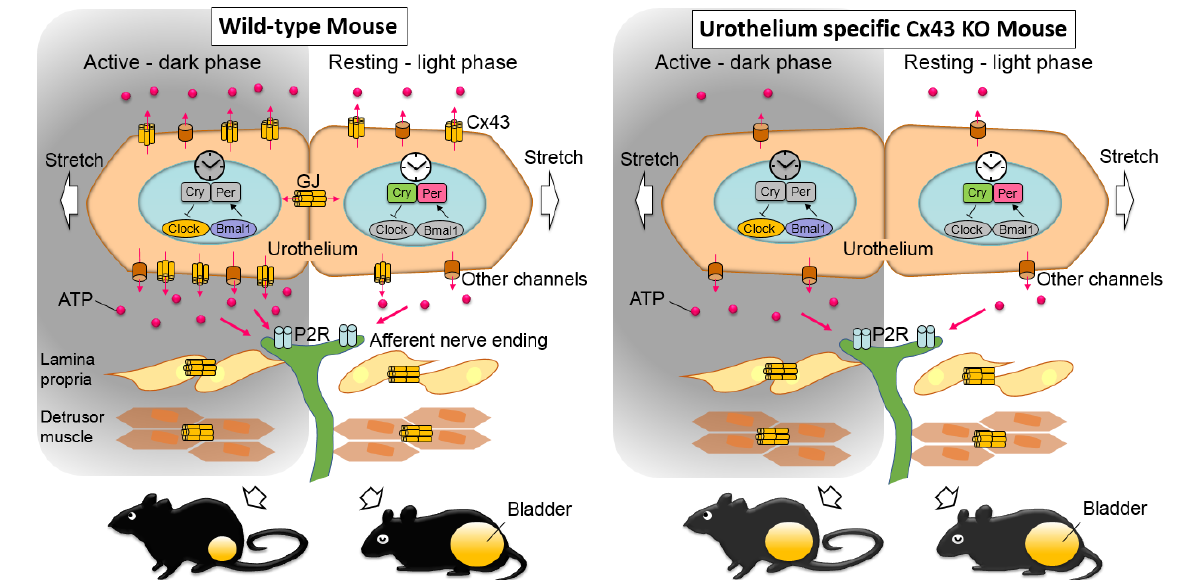
Figure 5. A schematic model of the events occurring in the wild-type mouse and in the urothelial specific Cx43 KO mouse, focusing on urothelial Cx43, ATP, and functional bladder capacity (Figure modified from supplement of [8]). In uCx43KO mice, downregulation of Cx43 expression in the urothelium results in reduced urothelial ATP release, especially in the animals’ active phase (night-time). The day–night differences in the urothelial ATP release and the functional bladder capacity are attenuated in uCx43KO mice that, in the active phase, displayed lower ATP release and higher functional bladder capacity than WT mice. Urothelial ATP signaling via Cx43 gap junction and hemichannel lead to stimulate P2 purinergic receptors (P2R) on the afferent nerve ending to modulate functional bladder capacity through other mechanisms. GJ, gap junction.